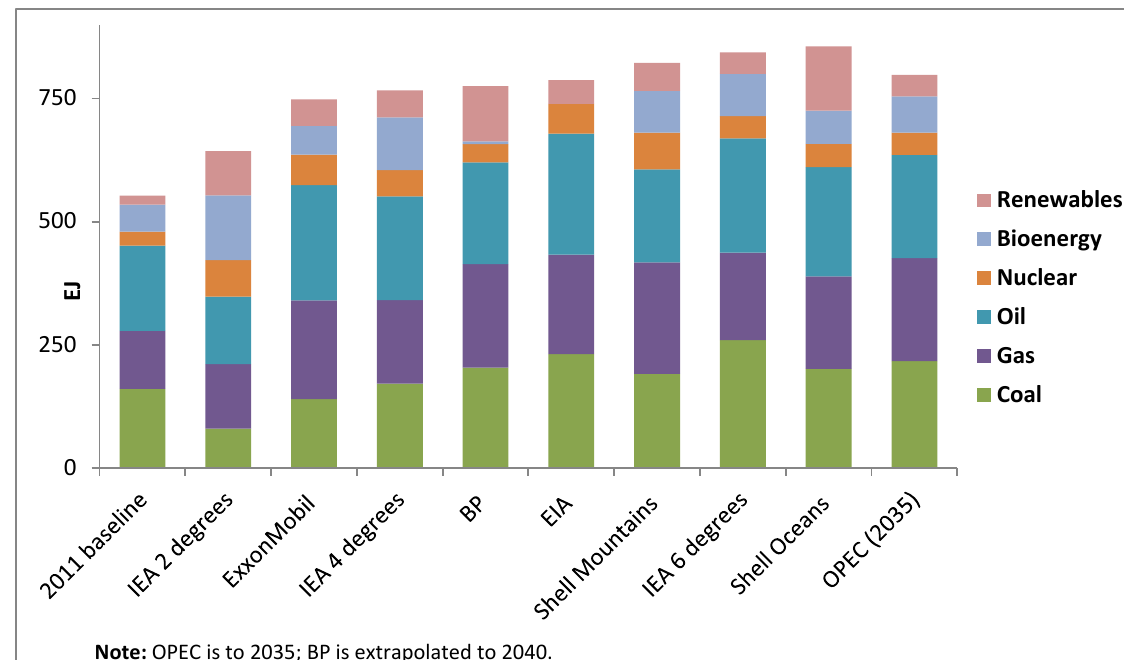
Figure 5. Primary energy demand in different global energy scenarios/projections for 2040